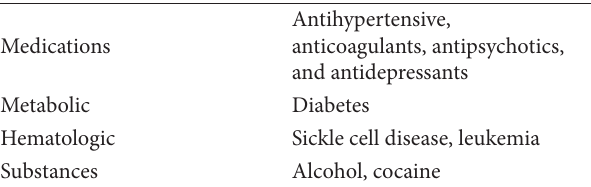
Table 1: Common causes of priapism [1,